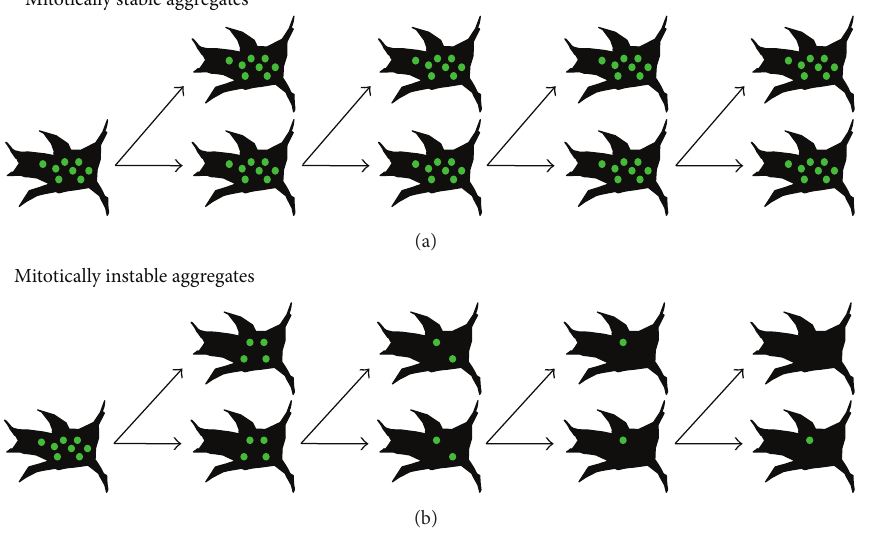
Figure 2: Mitotic stability of aggregate phenotypes is indicative of aggregate fragmentation. Dividing cells are a good model system to study propagation propensities of protein aggregates. (a) Proteins that can propagate as prions are mitotically stable in tissue culture, meaning that they are bidirectionally transmitted to daughter cells. Generation of infectious seeds that can self-propagate must be at least as fast as cell division. Prion aggregates must also be capable of escaping effective cellular clearance mechanisms. PrP Sc , NM derived prions [57, 58], and some SOD1 mutants [59] fulfill these criteria. (b) Many protein aggregates are mitotically instable. Unidirectional segregation during cell division might represent an evolutionary conserved mechanism to protect a subset of the progeny cells from toxic effects of protein aggregates. Relatively poor mitotic stability has been reported for polyQ aggregates [60,